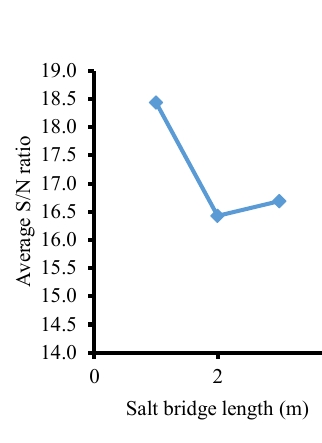
Fig. 9: Average S/N ratio for maximum cod reduction percentage